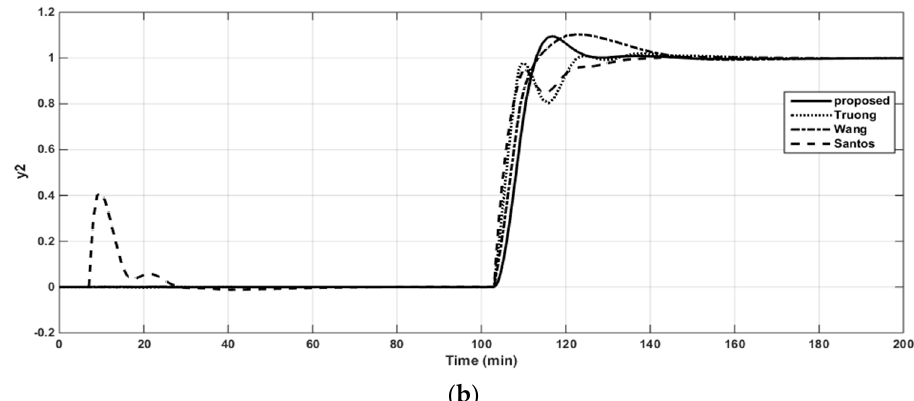
Figure 10. Closed-loop responses to the unit step changes in the set-point of loop 1 ( a ). Closed-loop responses to the unit step changes in the set-point of loop 2 ( b ).